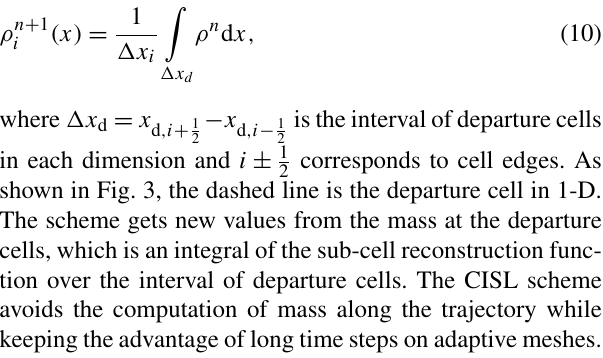
Figure 3. Illustration of the CISL scheme in 1-D and 2-D settings; α , β , and γ are labels of cells. u denotes the longitudinal velocity at cell edges. We set cell α as arrival cell in both the 1-D and 2-D cases, and hence the subscript i = α in Eqs. (10) and (13). The dashed line in the 1-D scheme is the departure interval, and the shaded area is the departure cell in the 2-D scheme. The 1-D CISL scheme follows Eq. (10) using a 1-D integral, while the 2-D CISL uses Eq. (13) with an area integral that uses a 2-D sub-grid distribution as a reconstruc- tion